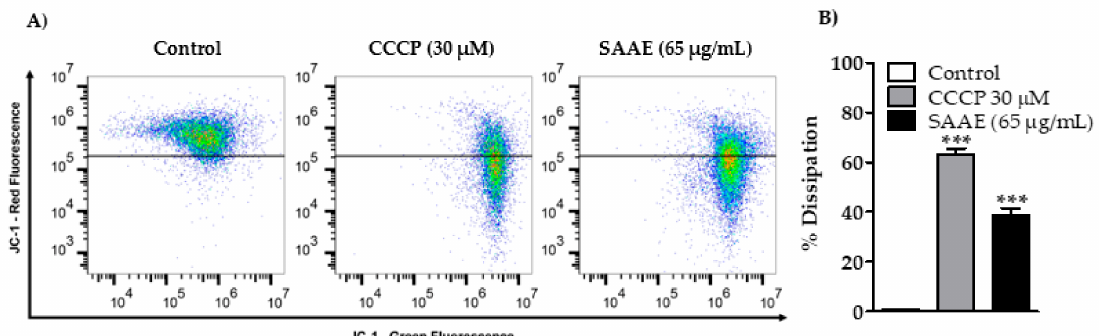
Figure 10. ( A ) Density Plot and ( B ) graphical representation of the percentages of mitochondrial membrane potential change in the control, CCCP-treated (30 µ M) and SAAE-treated (65 µ g/mL) B16F10Nex-2 melanoma cells. Data are expressed as the mean ± SEM ( n = 3) in duplicates. *** p < 0.0001 compared with the untreated control group.